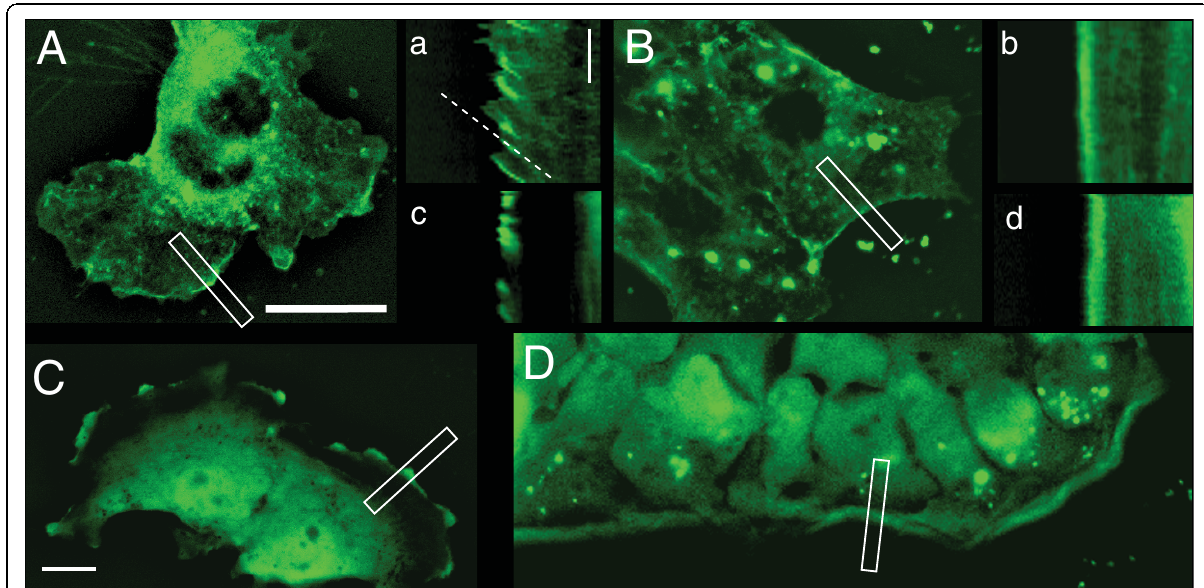
Figure 7 Plasma membrane ruffling is dependent on R-Ras . NMuMG cells stably transfected with GFP- b 1 -integrin (A, a) contained many ruffles (in 23/23 cells imaged) whose retraction from the cell edge can be observed in the accompanying kymograph (lowercase letters, corresponding to each panel). Cells transiently transfected with two different siRNA sequences targeting R-Ras did not have ruffles in 16/16 cells imaged (B, b) even though b 1 -integrin could be seen at thecell edge in portions of many cells. However kymography analysis of these areas reveals that the b 1 -integrin is dynamic in cells replete with endogenous R-Ras. (C, c and D, d) GFP-VSVG localizes to the bulk plasma membrane, suggesting that R-Ras has a more general effect on membrane ruffling. Ruffling that was observed in 15/15 cells imaged was abolished in 15/15 cells that were transfected with R-Ras siRNA. Scale bars = 20 μ m (A, B, C, D) or 10 mins (a, b, c,